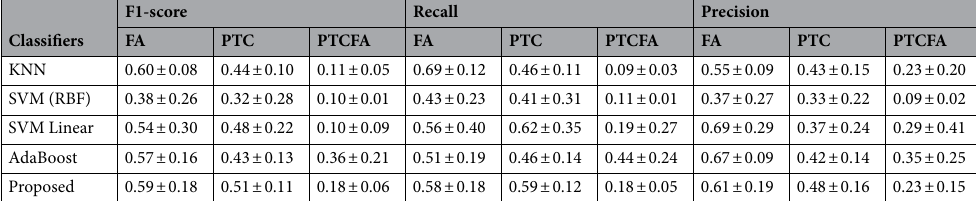
Table 2. Comparative performances (mean ± SD) of different classification